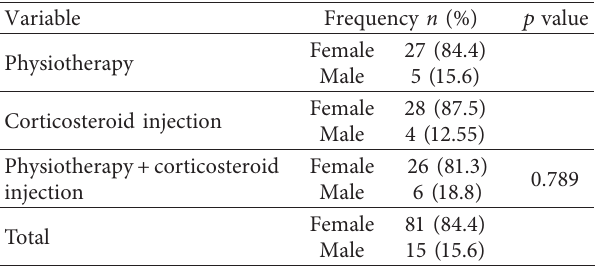
Table 1: Gender frequency distribution of patients in the three intervention